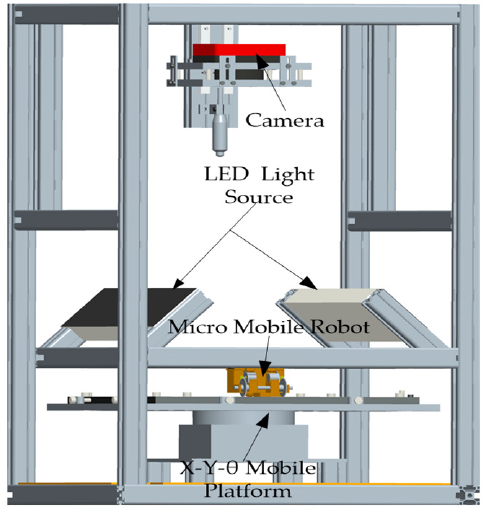
Figure 1. Visual detection platform for micro-mobile robot.